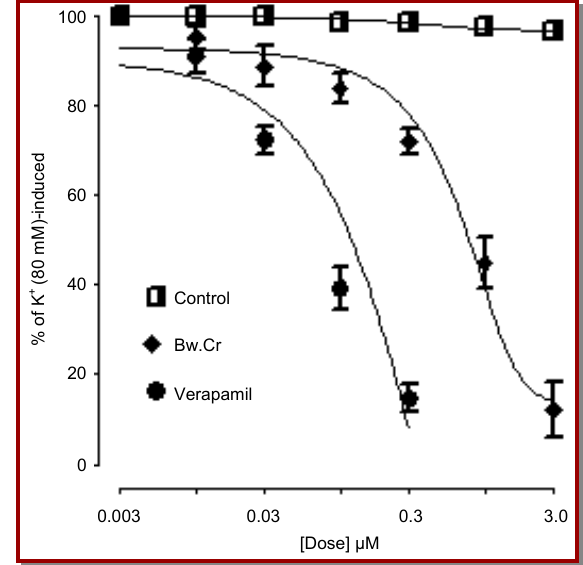
Figure 2 : Bar diagram showing the effect of the crude extract of B. wallichiana in comparison to the acetylcholine maximum response in isolated rabbit jejunum preparation (values are expressed as mean ± SEM, n = 3)